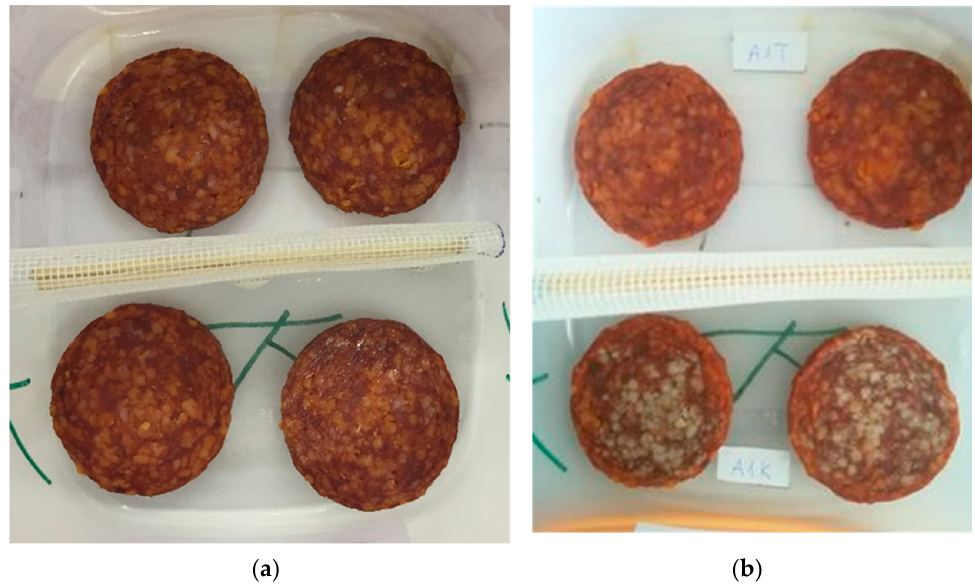
Figure 4. Sausage samples in the storage box at the beginning ( a ) and at the end ( b ) of the eight-week refrigerated storage (6 °C). Thymol-treated slices are in the upper parts, while untreated slices are in the lower parts of the photos.